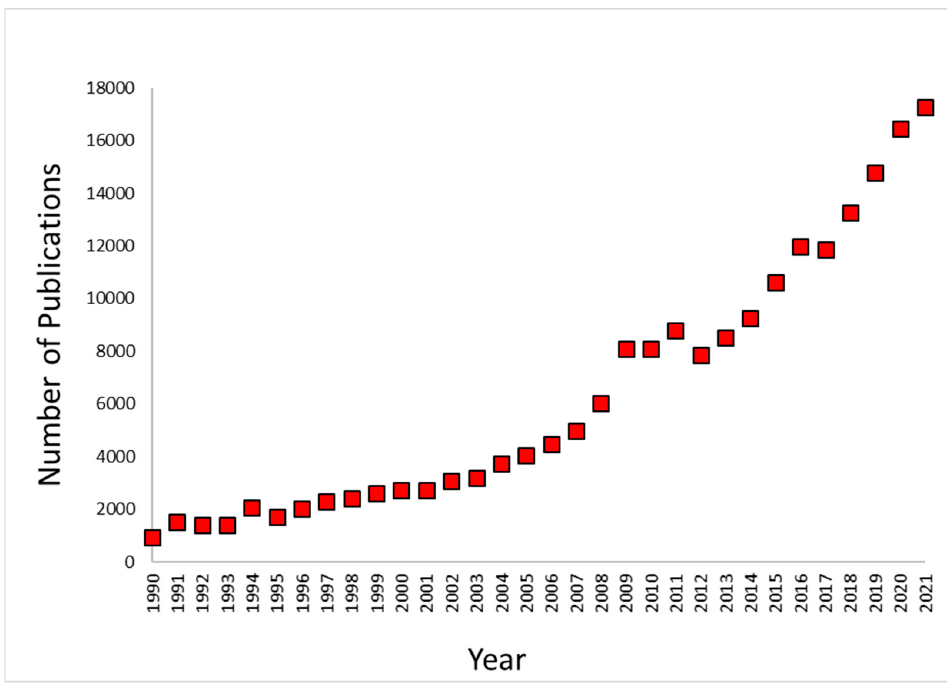
Figure 1. Number of publications in categories of either desalination or water treatment. Data taken from Scopus database, accessed 9 August 2022.